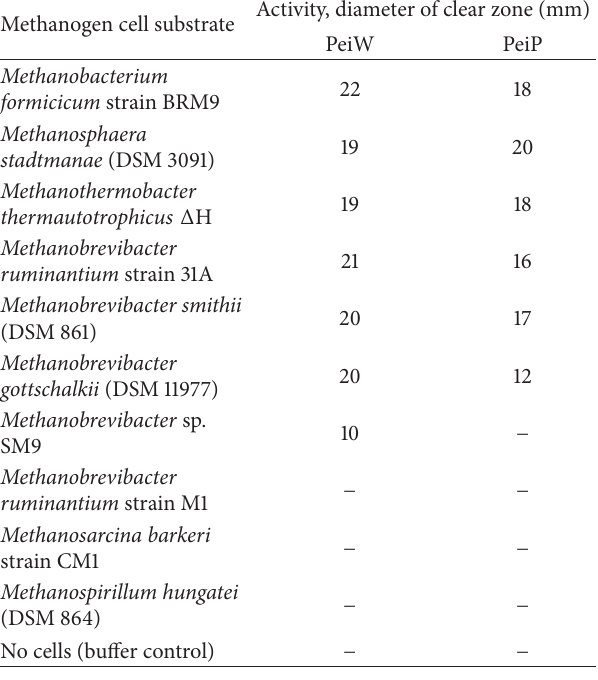
Table 3: Substrate specificity, activity of PeiW or PeiP on metha- nogen cells as substrates using an agarose plate lysate assay. Activity is diameter (mm) of clear zone produced in agarose plate. No clear zone is indicated by − . The diameter of the well was 4mm. No clear zones were observed with control buffer in the